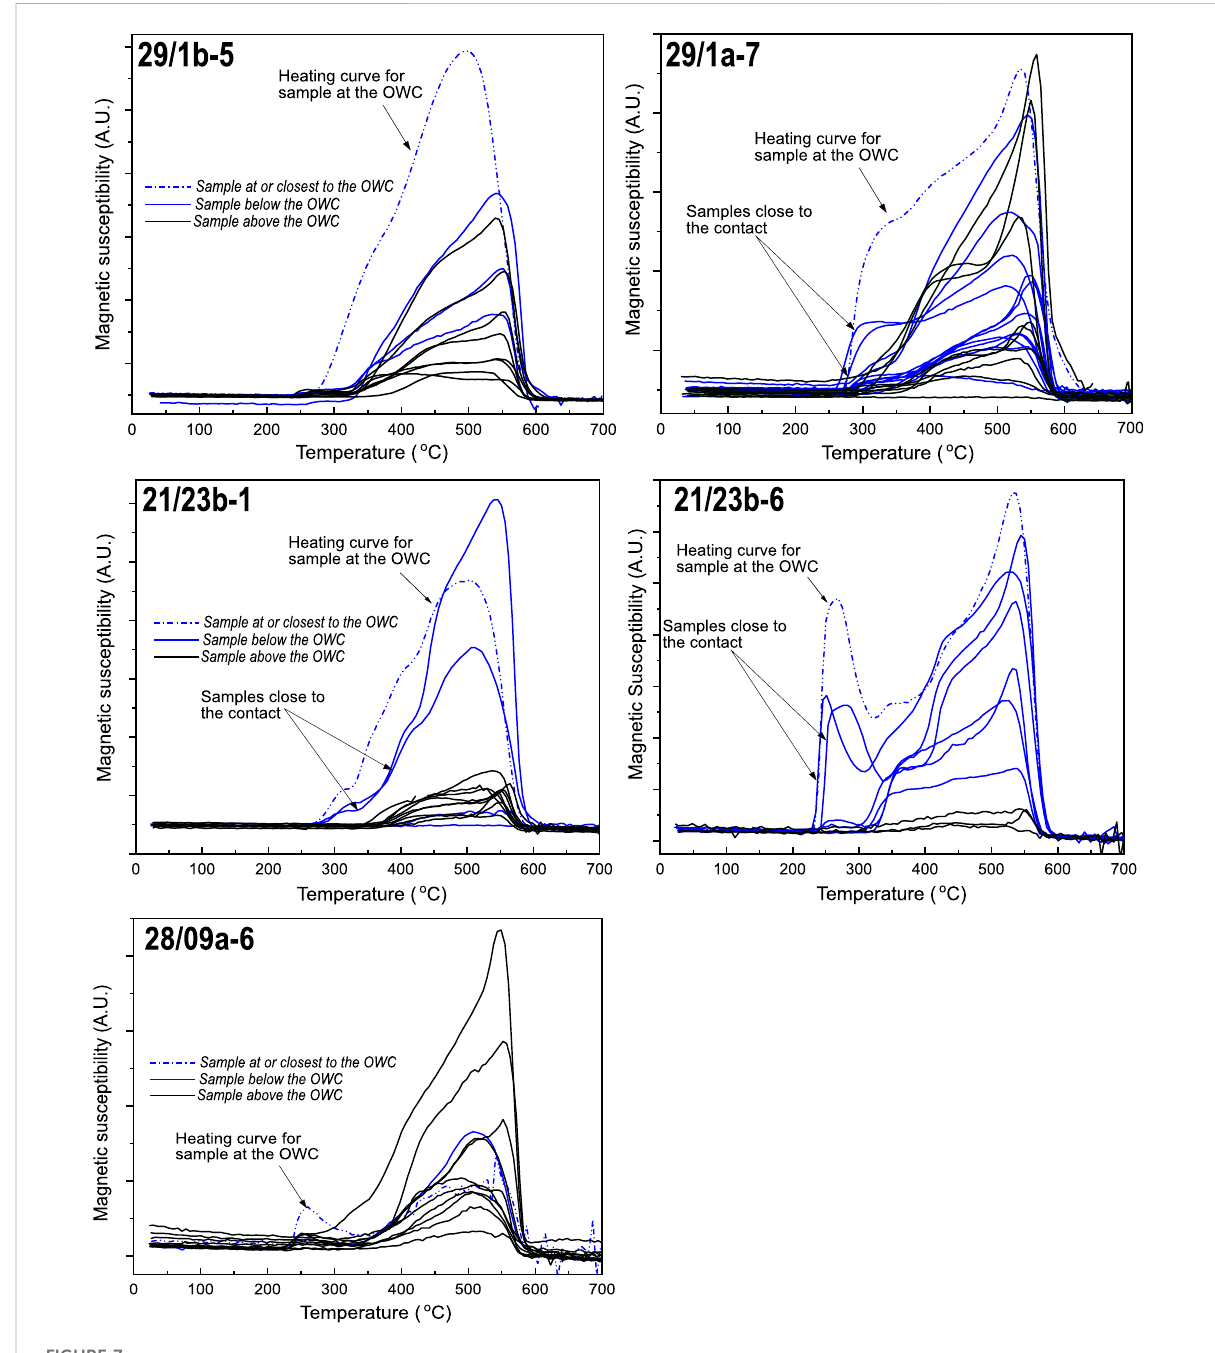
FIGURE 7 Overlaying the heating curves obtained per well. This emphasizes the differences in magnitude and trend of susceptibility as observed for the near OWC samples and those from the oil and water legs.